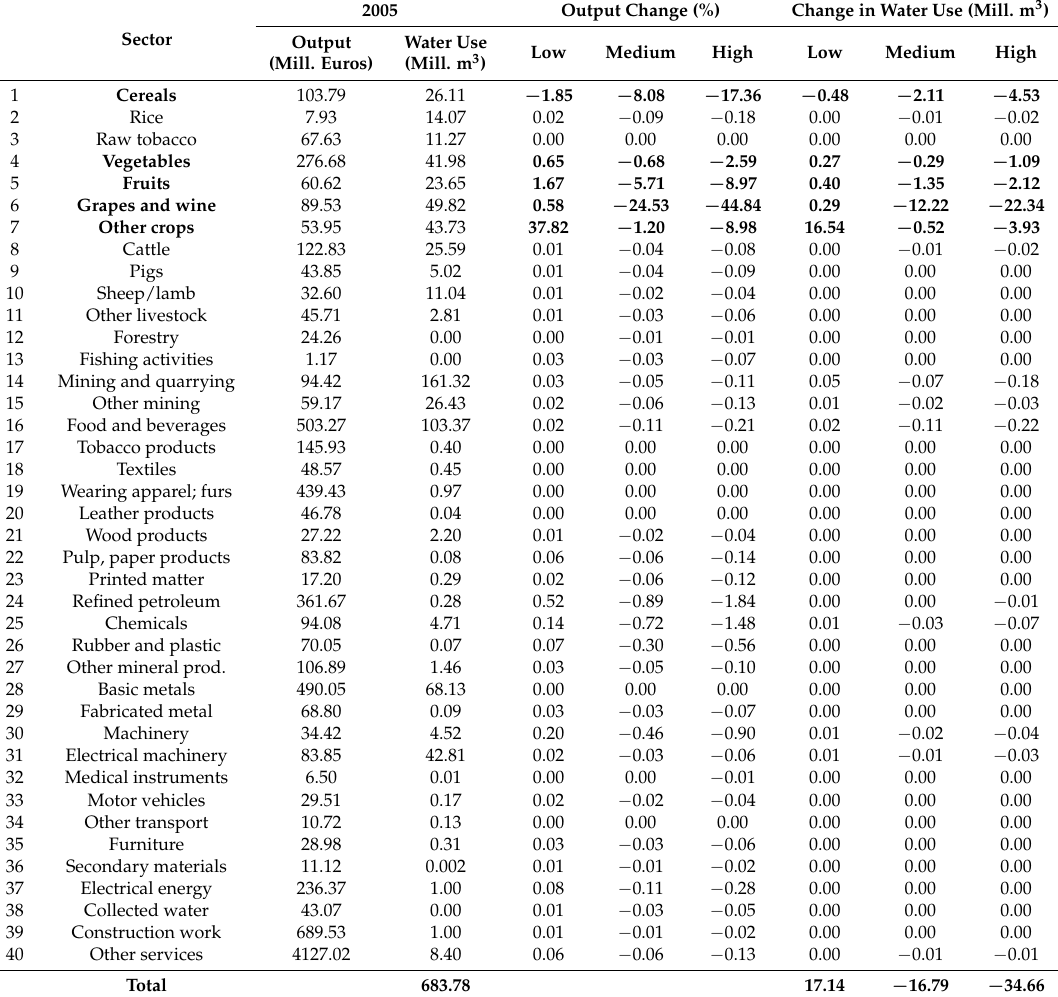
Table A1. Changes in output and water use due to different climate change scenarios, based on data on rainfed and irrigated land area taken from the 2007 Agricultural Census